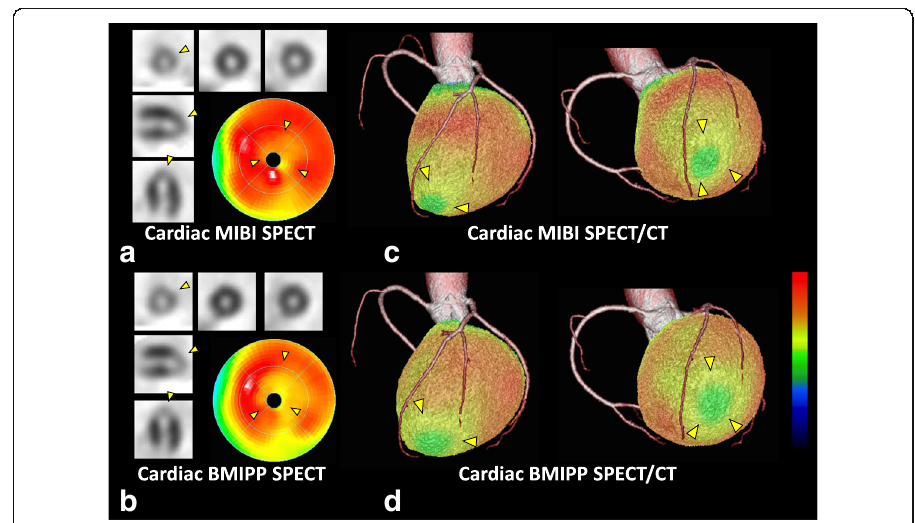
Fig. 5 68-year-old woman with TC. Cardiac MIBI and BMIPP SPECT images show accumulation defects in the distal anterolateral to apical wall ( a , b ). Due to the unclear alignment of accumulation defects with coronary artery territories, SPECT-only imaging could not differentiate between TC and ACS. SPECT/CT fused images revealed that the accumulation defect extended through distal LAD and first diagonal branch territories, confirming TC ( c , d )